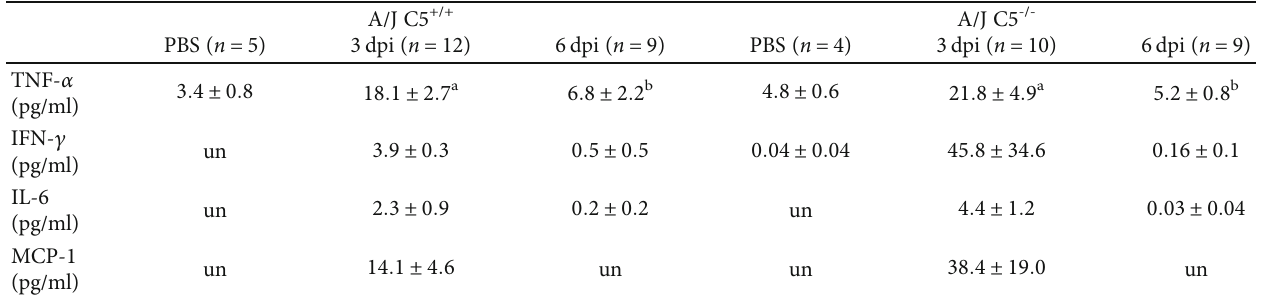
Table 2: Serum cytokine levels in A/J mouse strain infected by